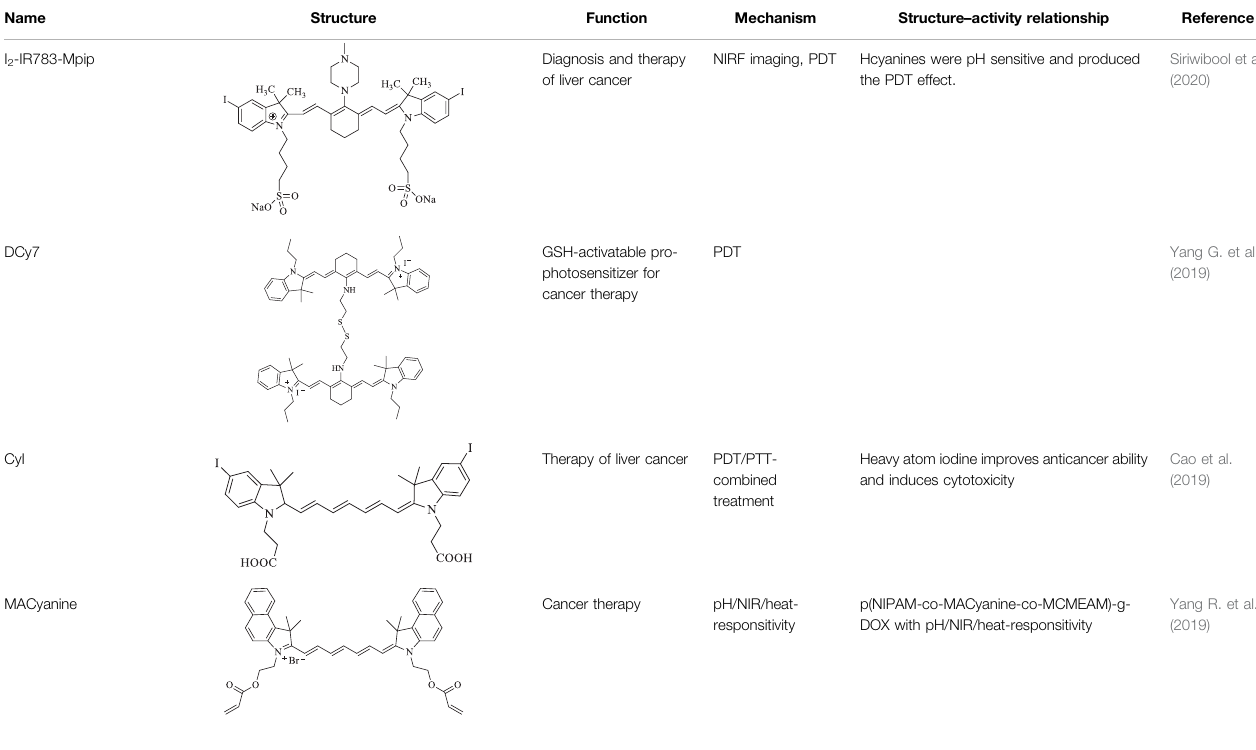
TABLE 1 | ( Continued ) Information on the structure and function of Cy7 and its